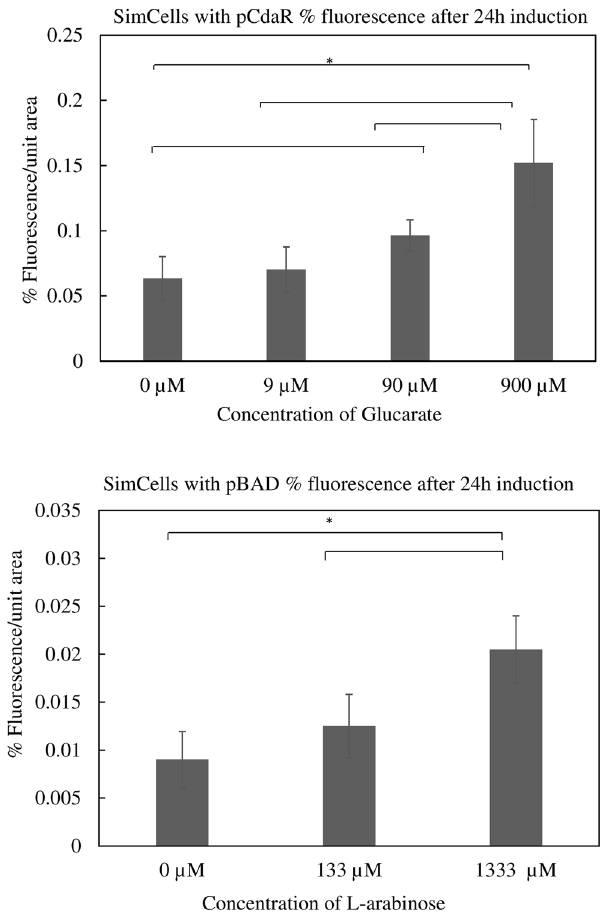
Figure 6. Quantification of fluorescent cells of SimCells with ( A ) pCdaR and ( B ) pBAD from light microscope images, expressed as % fluorescence per unit area. The data displayed are the average of 4 images, with one standard deviation above and below the mean. Asterisks denote significance at a 95% confidence